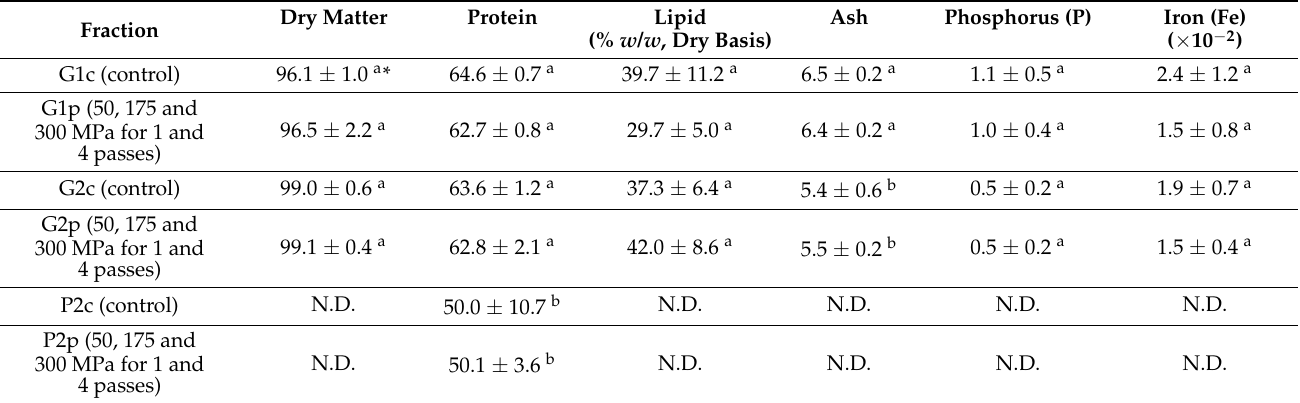
Table 1. Composition of control and pressure-treated fractions of egg